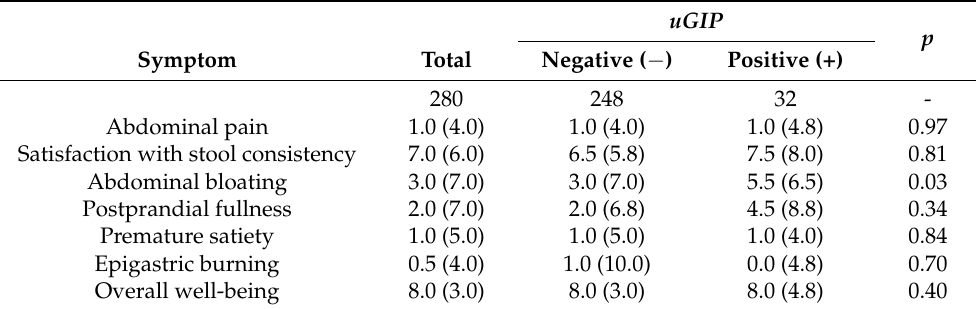
Table 2. Symptoms reported by visual analogue scales (VAS) in celiac patients with positive and negative uGIP.